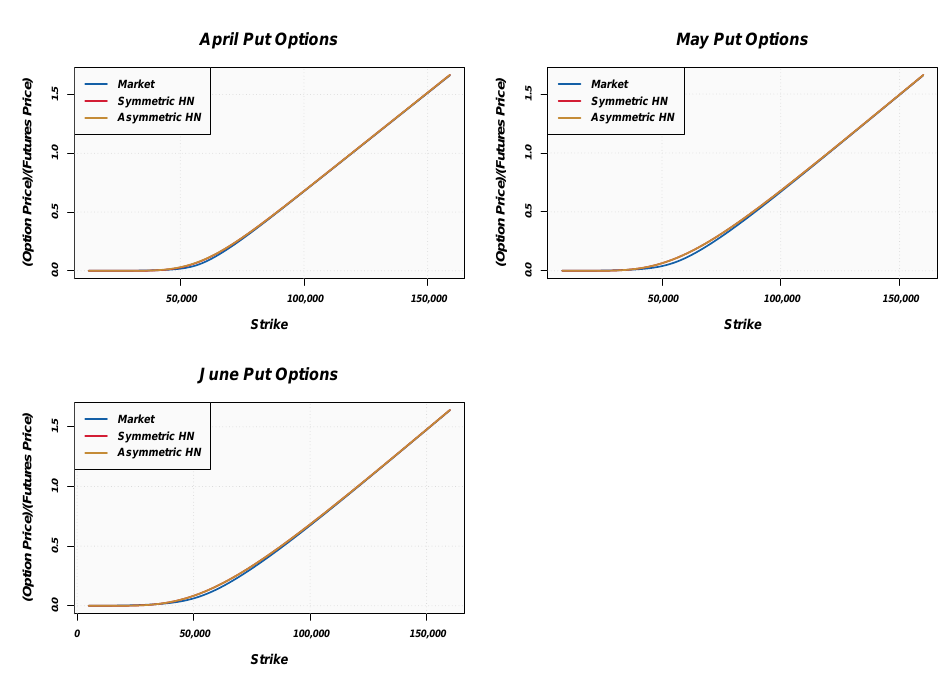
Figure 3. Bitcoin futures option prices. Table 5. April Performance Metrics.